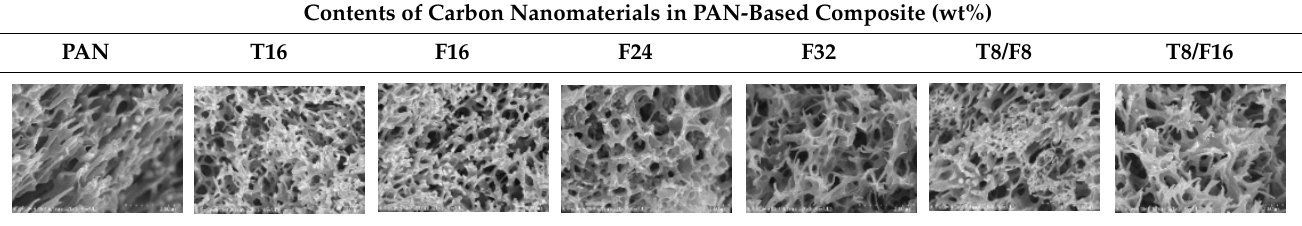
Table 6. Morphology of the PAN-based conductive yarn with different contents of carbon nanomaterials (×20,000). Contents of Carbon Nanomaterials in PAN-Based Composite (wt%) PAN